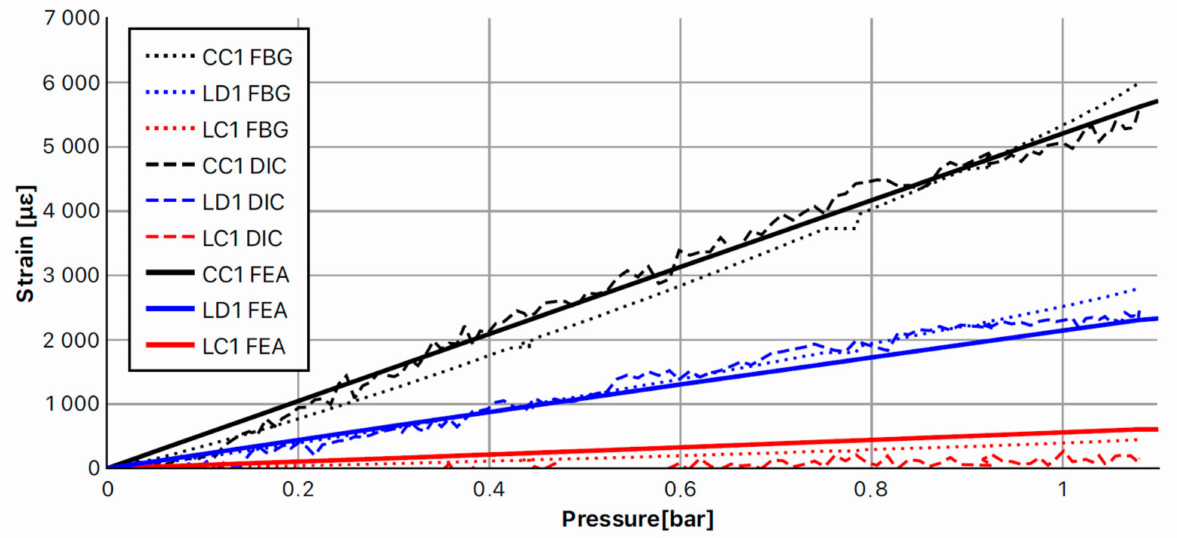
Figure 16. Chart presenting deformations recorded using FBG sensors, DIC method, and FEA